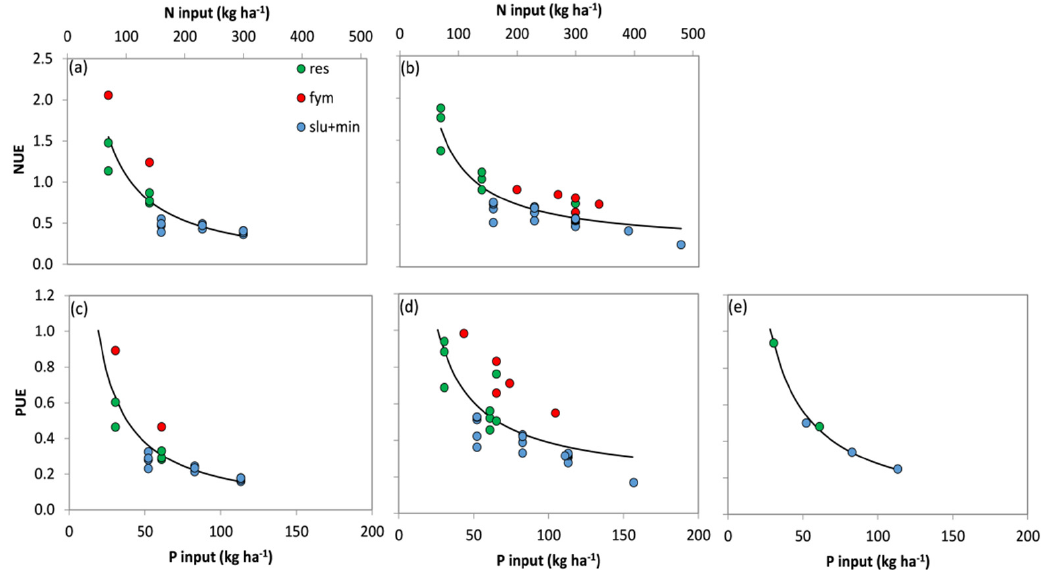
Figure 2. Relationship between nitrogen ( a , b ) and phosphorus ( c – e ) fertilisation levels and the average output-to-input ratio (i.e., NUE and PUE) for winter wheat ( a , c ), maize ( b , d ), and soybean ( e ) during the long-term experiments. The black line represents the interpolated hyperbolic model, and the points represent LTE observations, clustered according to the different agronomic inputs, i.e., res: crop residues incorporation in green, fym: farmyard manure in red, and slu+min: slurry + mineral fertiliser application in blue.